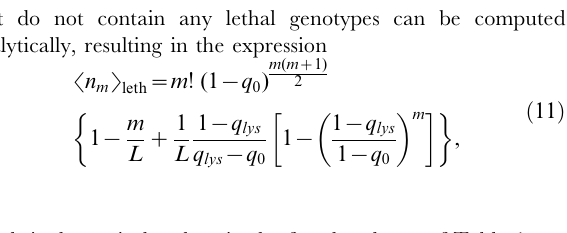
Figure S1 Plot of 1 { p L (0) as function of 1 = L for the HoC model. While the extrapolation to 1 = L ~ 0 is not straightforward, 1 { p L (0) clearly decreases monotonically with a limiting value below 0 : 1 . Figure S2 Simulation results for the probability of finding no accessible path in the LK model when the number of non- interacting loci L { K is kept fixed. Figure S3 Simulation results for the mean number of accessible paths for the LK model. Figure S4 Simulation results for the probability of finding no shortest connected path between two viable antipodal genotypes for the holey landscape (neutral) model at different viability probabilities p . In these simulations the initial genotype and its antipode were constrained to be viable. Figure S5 Mean number of accessible paths obtained from subgraph analysis of the A. niger landscape (diamonds with error bars) compared to the results of a subgraph analysis of LK landscapes with L ~ 8 , K ~ 4 (circles) and K ~ 5 (squares) and K ~ 7 (triangles). Figure S6 Distribution of the number of accessible paths in the RMF model with L ~ 7 . Note that the behavior for the HoC-case h ~ 0 is typical for small values of h with most of the probabilistic weight on n ~ 0 . This changes for larger values of h , where